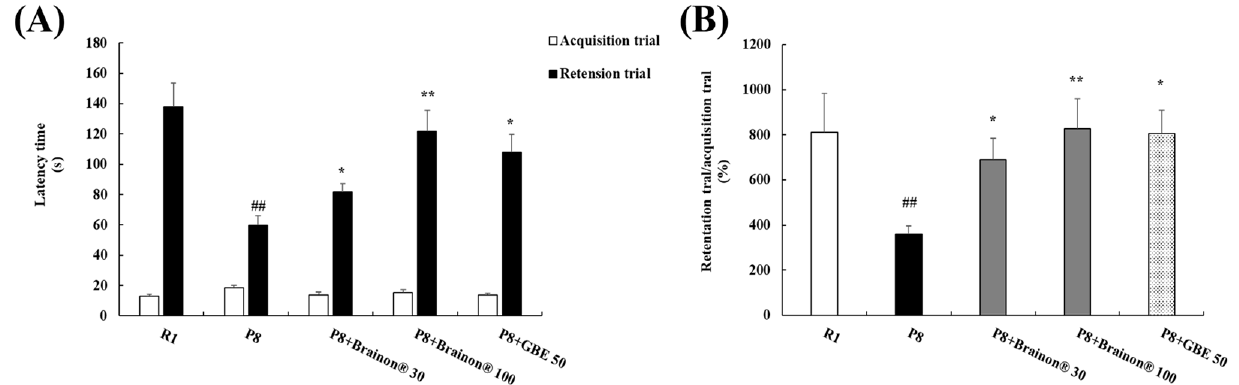
Figure 4. Brainon ® ameliorates learning and memory impairments in the passive avoidance task. ( A ) The latency times to enter the dark compartment were recorded in acquisition and retention trial. ( B ) The percentage ratio of the retention trial latency to acquisition trial latency was calculated for each mouse. Data are expressed as mean ± SD of independent experiments ( n = 6). ## p < 0.01 vs. R1 (SAMR1) group; * p < 0.05 and ** p < 0.01 vs. P8 (SAMP8) group.